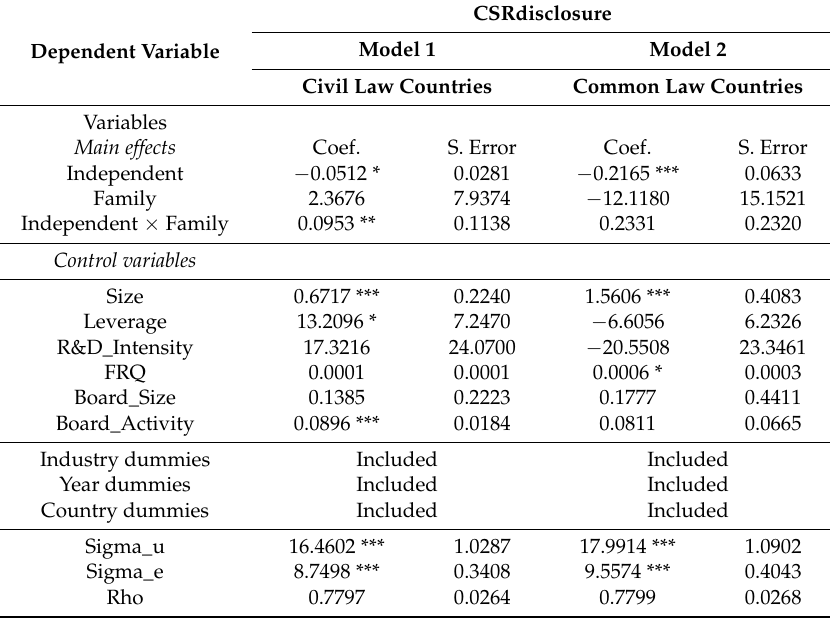
Table 7. The Impact of Board Independence on CSR Disclosure in Family owned firms for Civil and Common Law